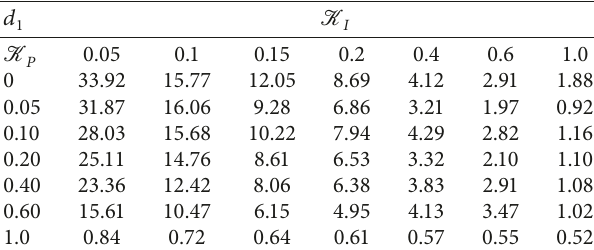
for various control gains in Corollary 1. 1